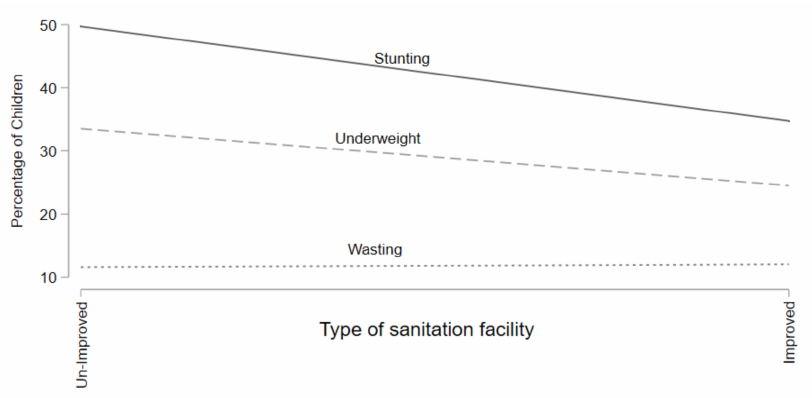
Figure 1. Prevalence of Stunting, Underweight, & Wasting for Sanitation Facility.